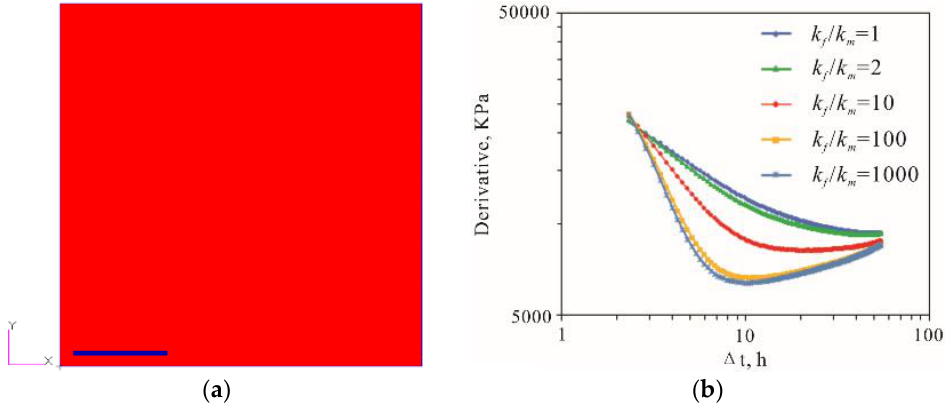
Figure 7. ( a ) Near-wellbore model with one fracture (blue); ( b ) Comparison of derivative plots with different k f / k m